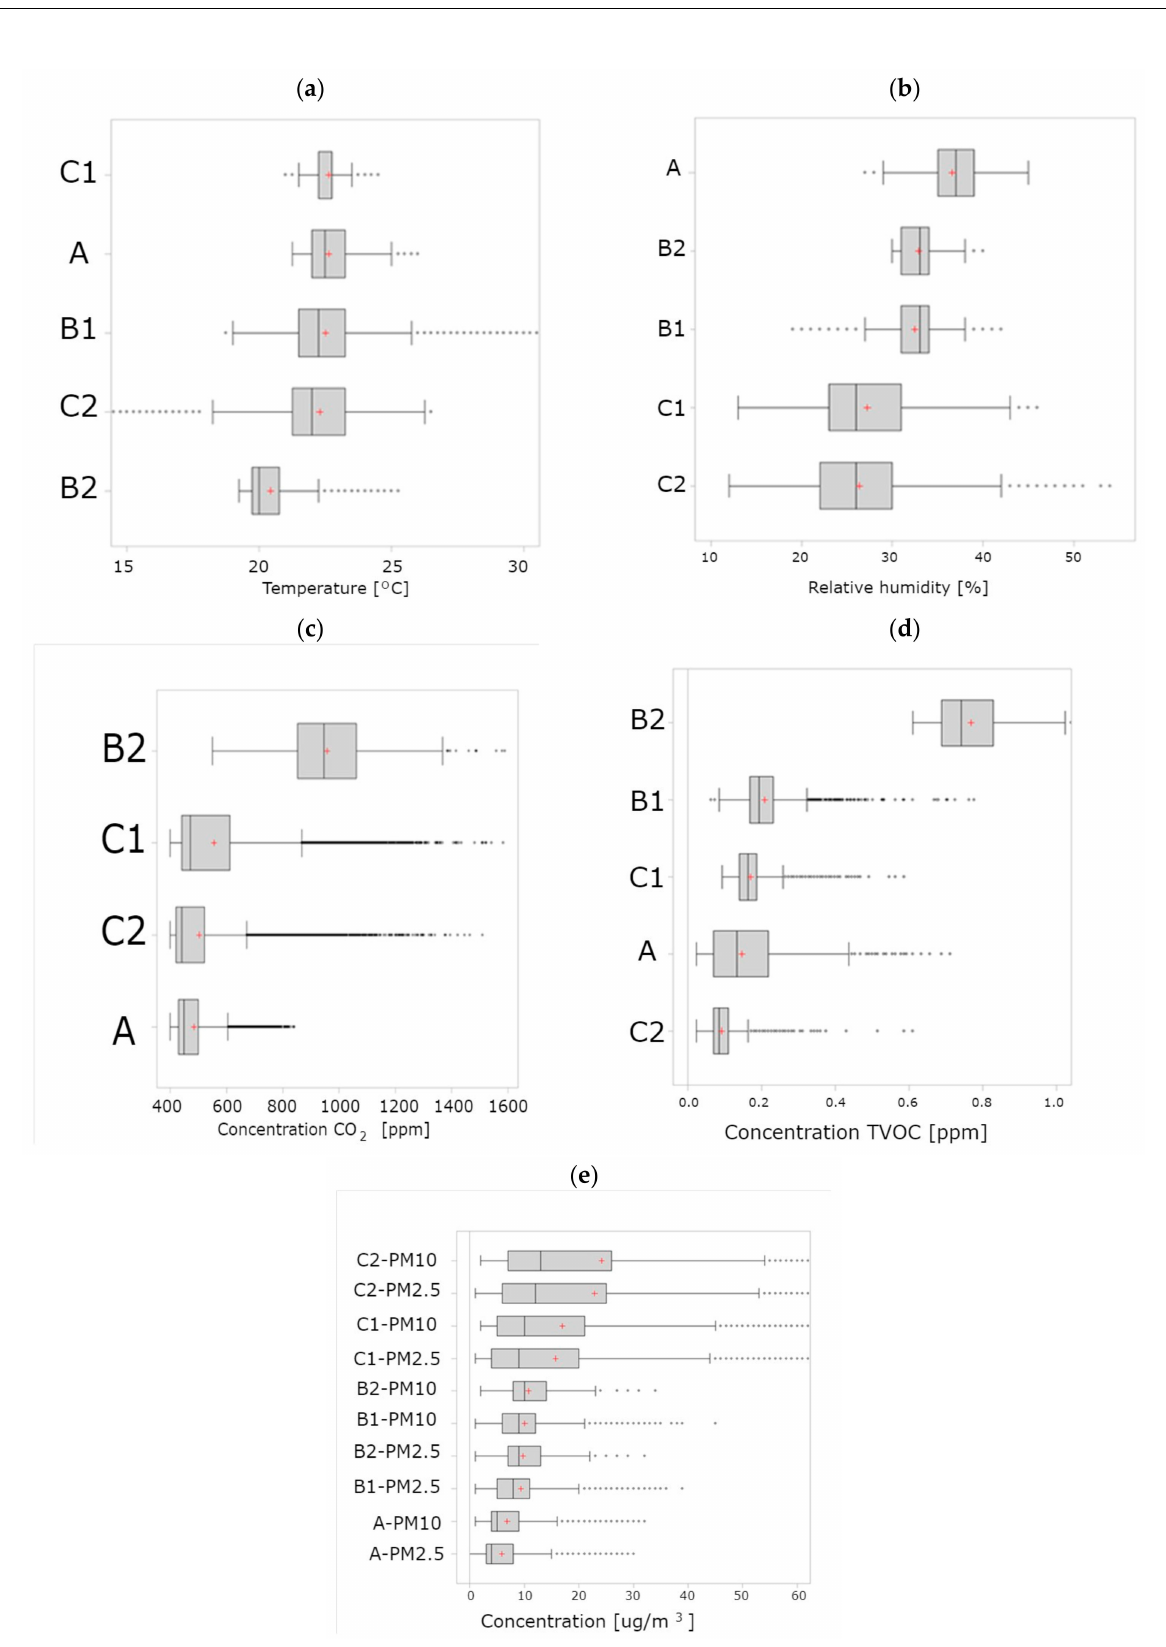
Figure 2. Box plot for IAQ; ( a ) Indoor temperature; ( b ) relative humidity; ( c ) carbon dioxide; ( d ) con- centration of volatile organic compounds; and ( e ) dust concentration—fraction: PM2.5 and